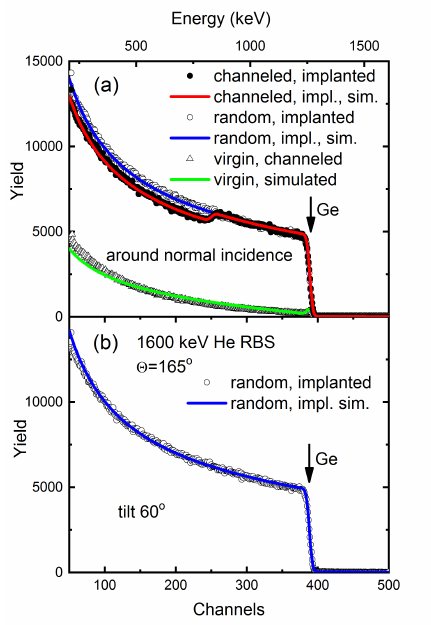
Figure 2. Comparison of measured (symbols) and simulated (lines) RBS spectra of the Al-implanted Ge sample ( a ) in channeling conditions around normal incidence. The channeling spectrum of virgin Ge is also shown ( b ) in random conditions at the sample tilt of 60 ◦